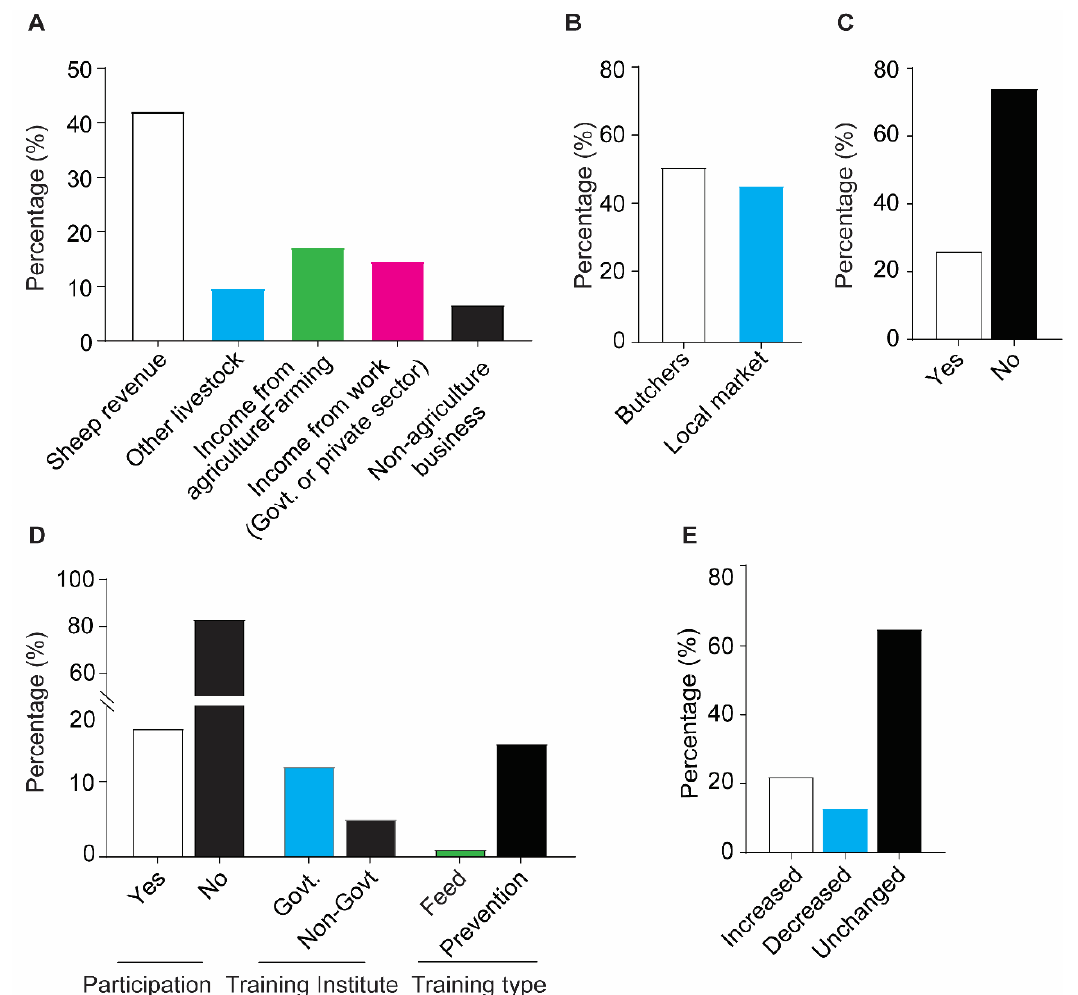
Figure 5. Sheep contribution to farmer’s livelihood and practices of rearing sheep. ( A ) Household income ( B ) Sheep sale channels ( C ) Improvement in livelihood due to sheep farming ( D ) Farmers training regarding livestock rearing ( E ) Practices of rearing more sheep.